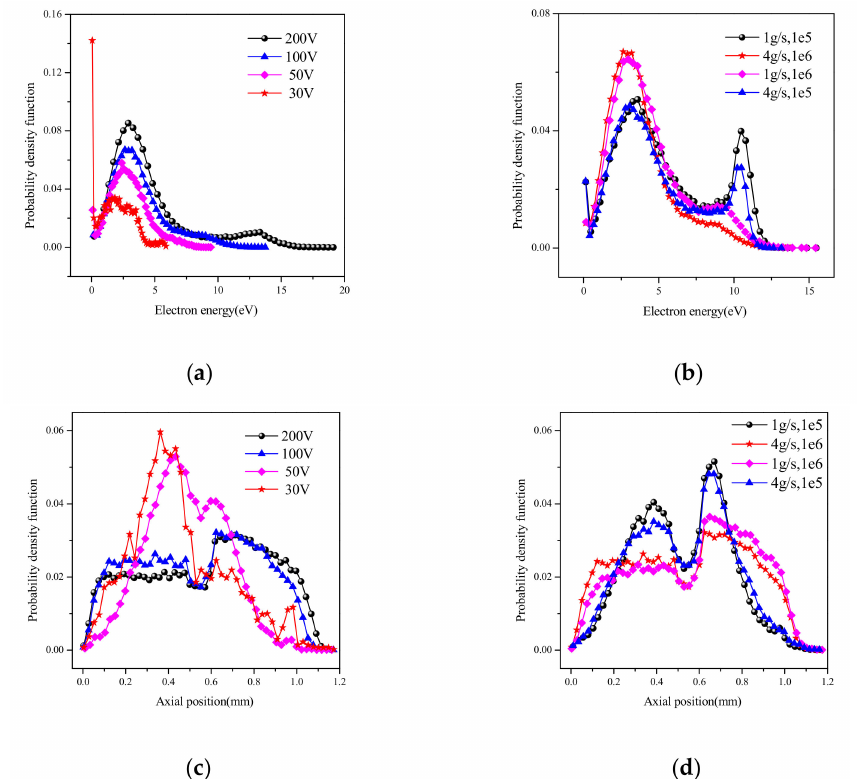
Figure 7. Probability density function with electron energy in ( a ) di ff erent discharge voltages at 4 g / s, 10 6 and ( b ) di ff erent mass flow rates or particle weights at 100 V, with axial position in ( c ) di ff erent discharge voltages at 4 g / s, 10 6 and ( d ) di ff erent mass flow rates or particle weights at 100 V.